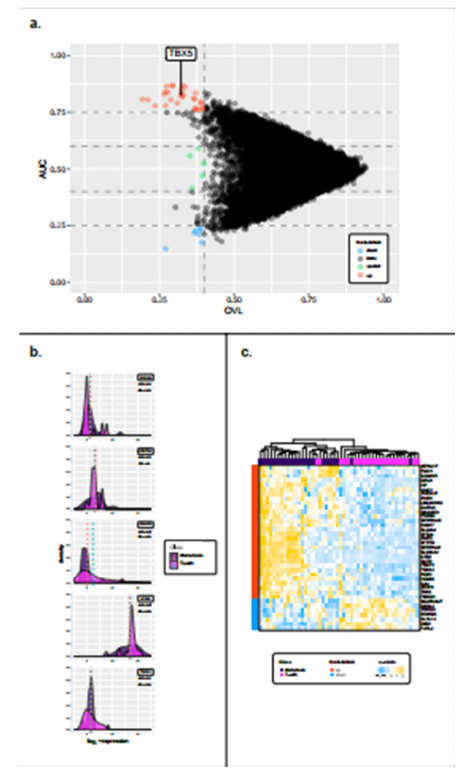
Figure 3. Identification of significantly regulated genes in T-with tumors compared to paired DM tumors. ( a ) Arrow plot showing genes in the OVL–AUC plane. Genes with an OVL value less than 0.4 are considered to be of interest. Those having an AUC > 0.75 are considered to be up-regulated in the metastasis group (red dots), whereas those having an AUC < 0.25 (below the lower horizontal dashed line) are considered to be down-regulated (blue dots). Genes having 0.4 < AUC < 0.6 (those lying between the second and third horizontal dashed lines) are the special genes (green dots). ( b ) Density plots showing the distribution of the five special genes (ZNF491, COX7A1, CRABP1, EP300, TRPC4). ( c ) Heatmap clustered by Euclidean distance and the complete linkage method representing gene expression levels for the up- and down-regulated genes in the primary and metastasis groups. On the left of the figure, the red and blue bars specify whether the genes are up- or down-regulated respectively, while on the top, the purple and magenta squares indicate if samples belong to the metastasis or primary tumors groups, respectively. Gene expression levels colors range from blue (low expression), to white (mild expression), to yellow (high